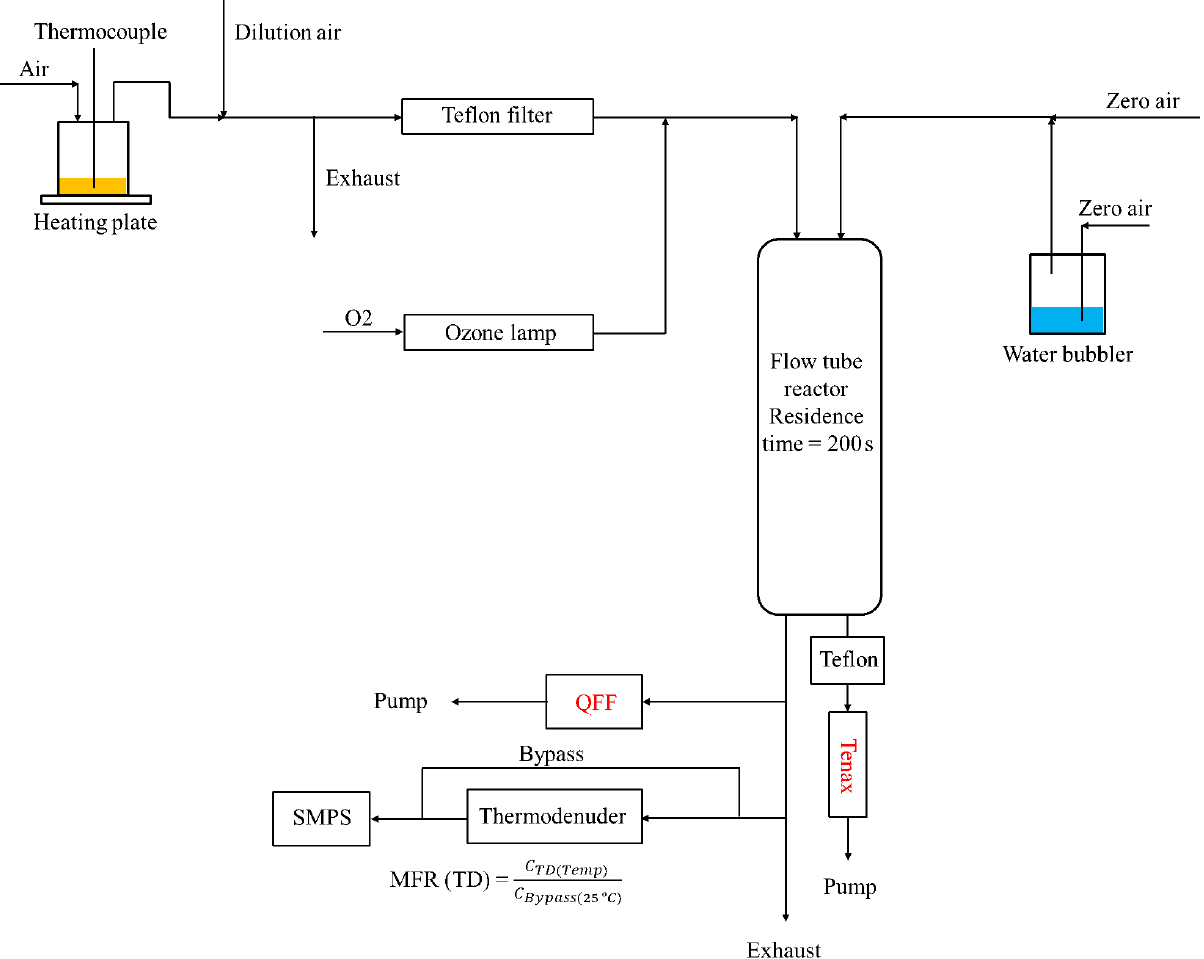
Figure 1. Experimental setup for oxidation of heated-cooking-oil emissions.